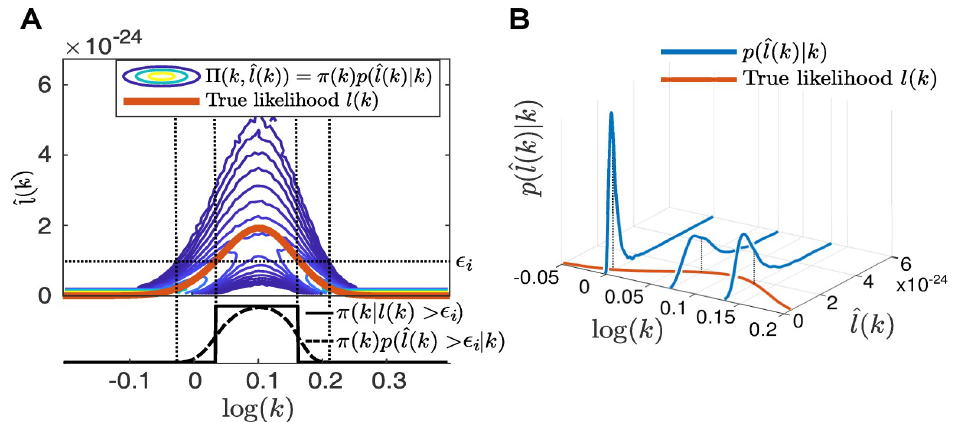
Fig 2. Illustration of likelihood approximation with a particle filter. A : Top: Likelihood for different parameters k (red) and contour lines of the joint distribution P ( k , log( k ) of the parameter k and its likelihood approximation ^ l ð k Þ , based on 10 6 samples of the likelihood approximation obtained with a particle filter with 100 particles. Bottom: The constrained priors π ( k | l ( k ) > � ) and p ð k Þ p ð ^ l ð k Þ > � j k Þ for � = 1 e − 24. B : Example distributions p ð ^ l ð k Þj k Þ (blue) for k = 1, 1.2 and 1.4 and the true likelihood l ( k )